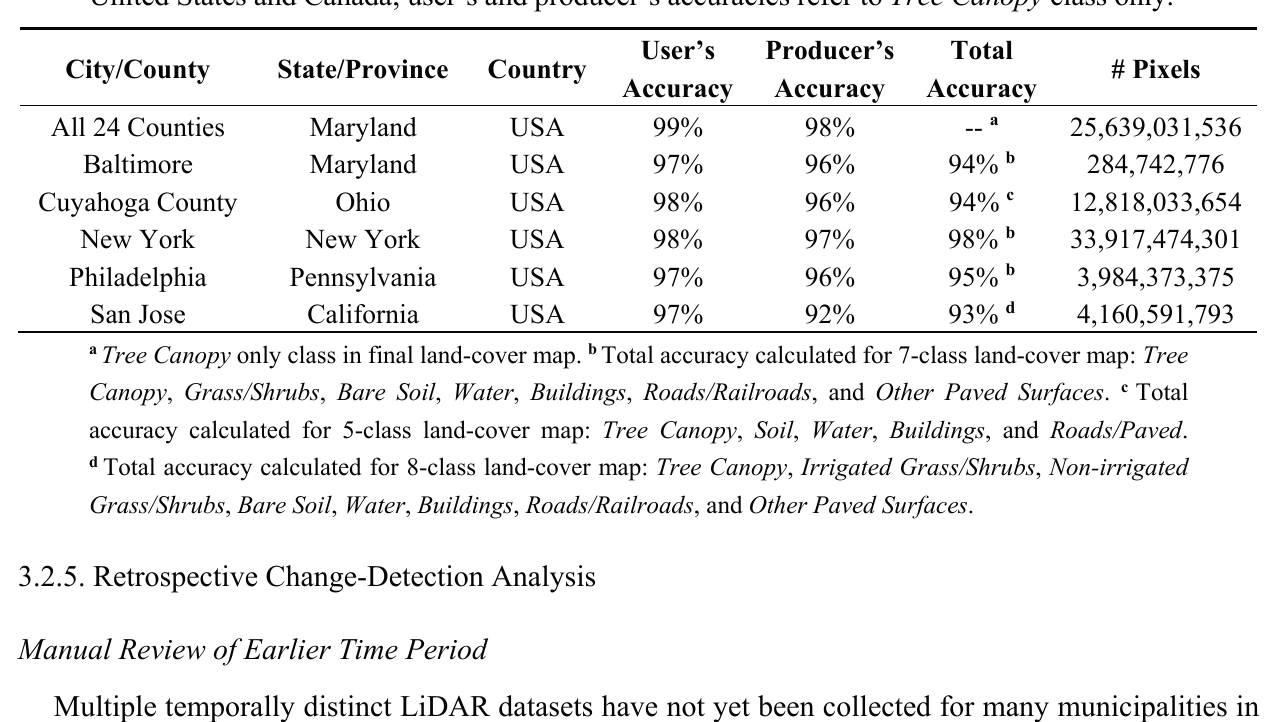
Table 2. Per-pixel accuracy assessments for selected Tree Canopy (UTC) assessments in the United States and Canada; user’s and producer’s accuracies refer to Tree Canopy class